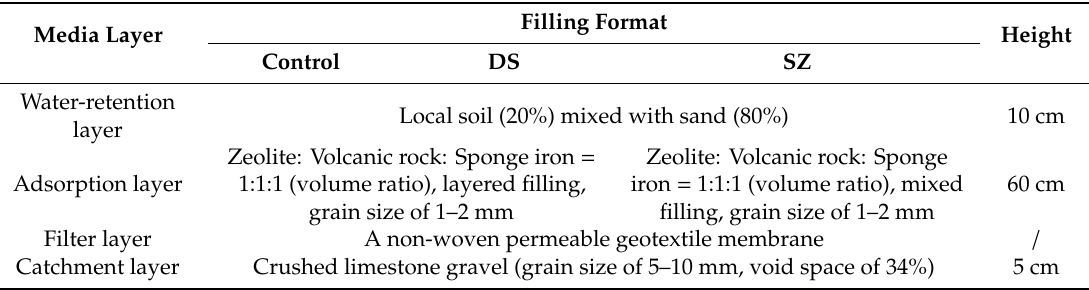
Table 1. Filling method for media layer in the infiltration column.